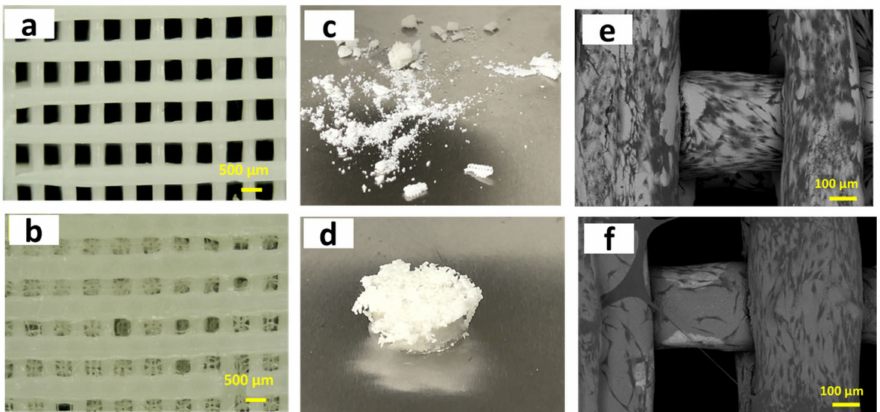
Figure 15. Microscopic images of ( a ) ZC and ( b ) ZCB. Digital photograph of ( c ) ZC and ( d ) ZCB after the compression test. Cell-attachment analysis using FE-SEM of the ( e ) Z and ( f ) ZC groups. Images used from Sakthiabirami et al. [106] reprinted with permission from Elsevier, copyright©